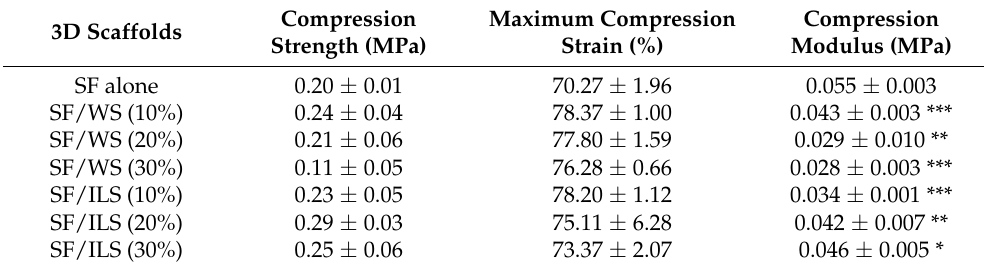
Table 3. Compression strength, maximum compression strain, and compression modulus of SP composite 3D.